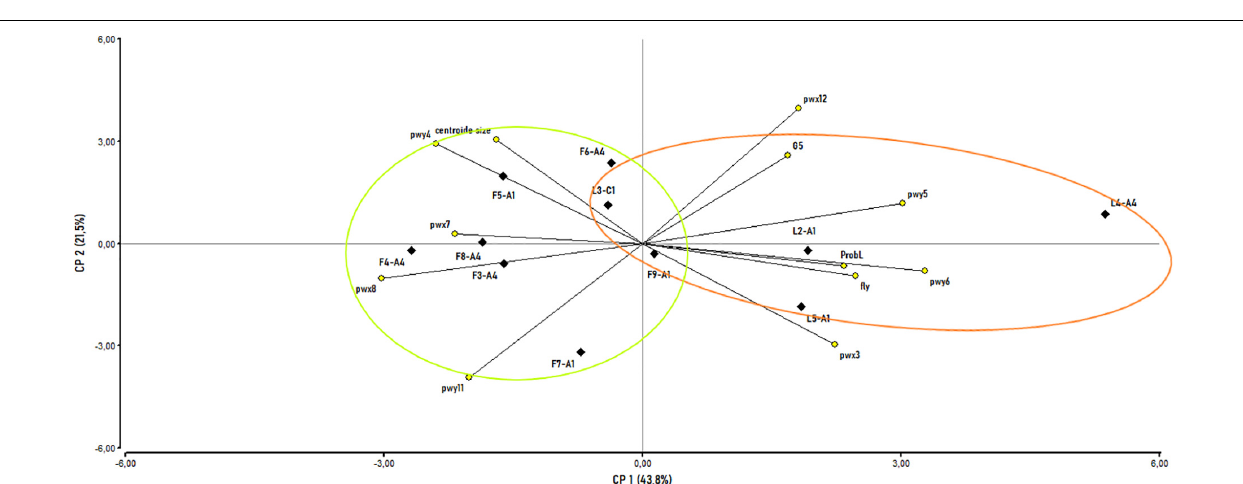
FIGURE 6 | Defensive behavior of A. mellifera colonies from Leales (LE) and Famaillá (FAM) apiaries through the beekeeping season (2017–2018). Mean values ( ± SE) for “run” (A) ; “fly” (B) ; “hang” (C) ; and “sting” (D) are shown.